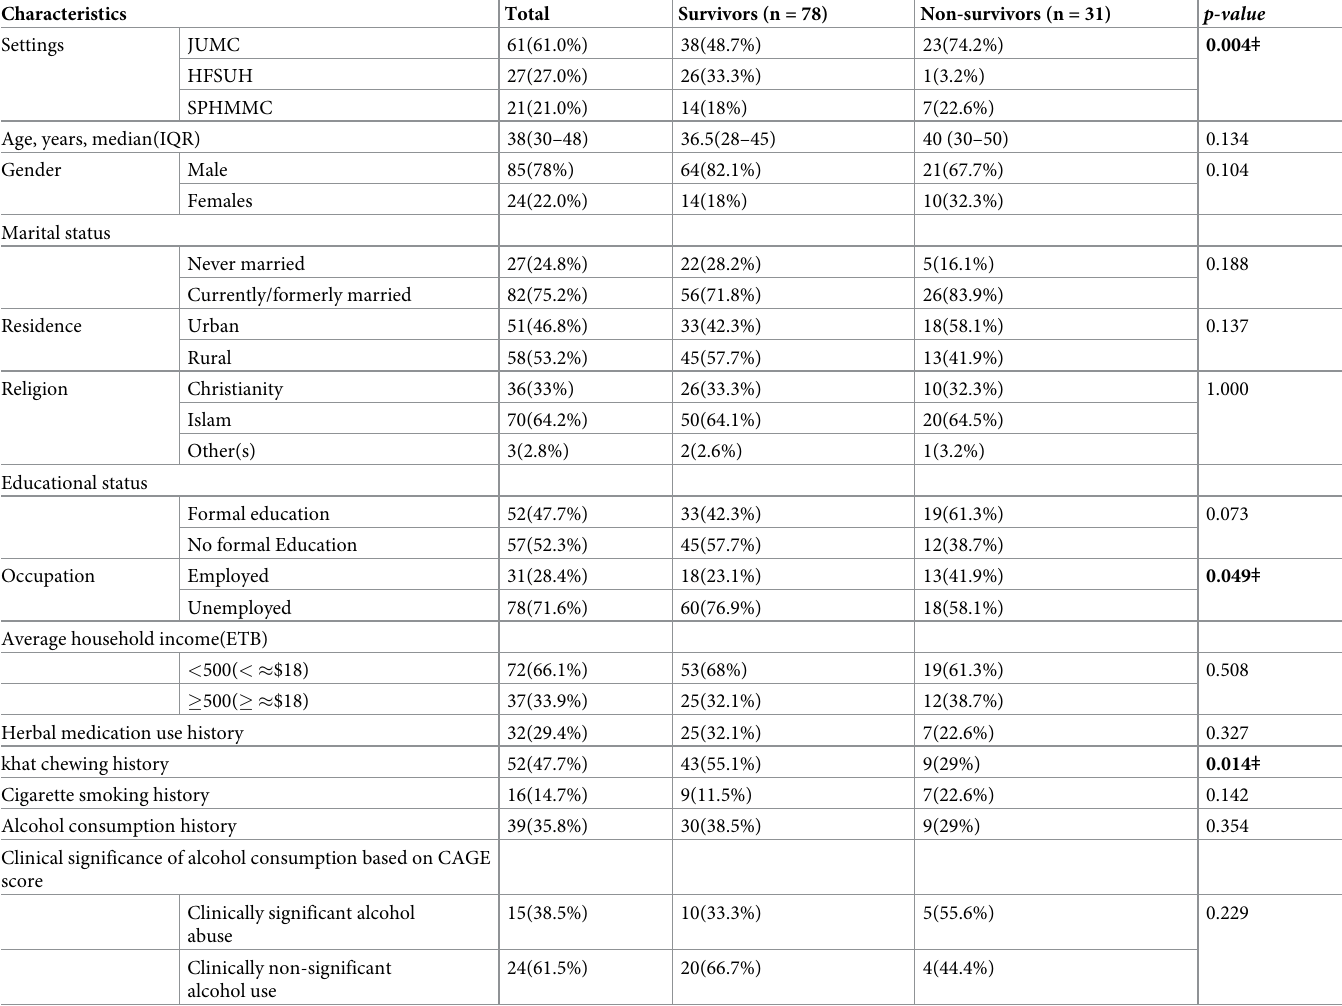
Table 1. Socio-demographic and behavioral characteristics of CLD patients in relation to their association with in-hospital